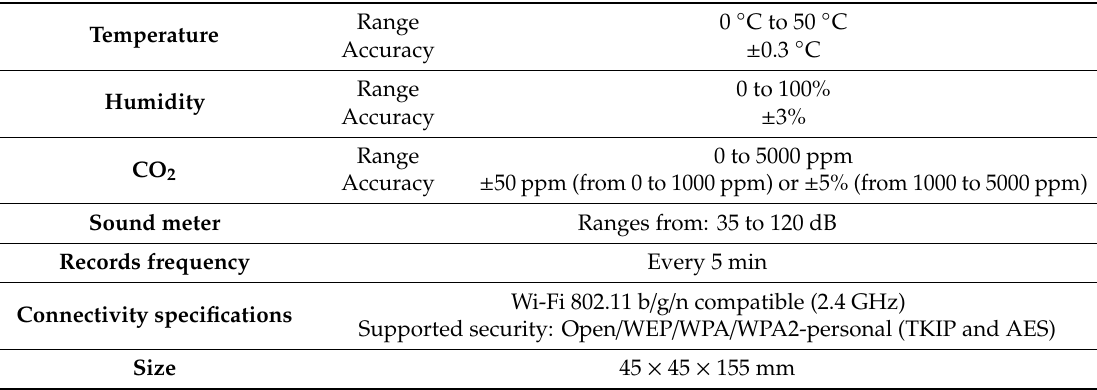
Table 3. Specifications of the Netatmo Indoor Air Quality Monitor. Data from